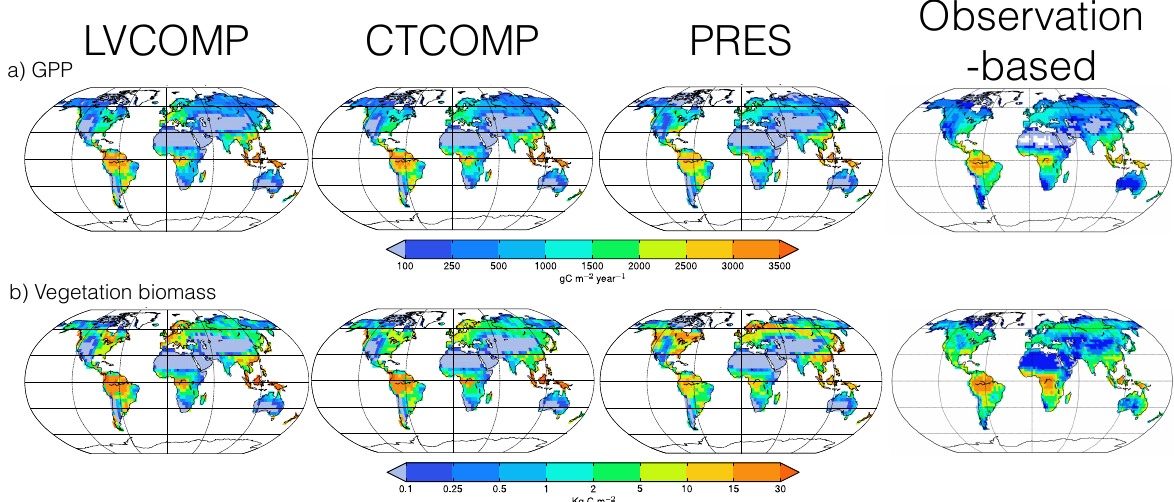
Figure 7. Geographical distribution of modelled GPP (a) , and vegetation biomass (b) from simulations that use dynamically modelled fractional coverage of PFTs based on the original L–V equations (LVCOMP, leftmost column), and the modified L–V equations (CTCOMP, second column). The third column shows simulation results that use prescribed PFT fractional cover based on the modified Wang et al. (2006) data set (PRES). The fourth column has observation-based data sets of GPP (Beer et al., 2010) and vegetation biomass (Ruesch and Holly,